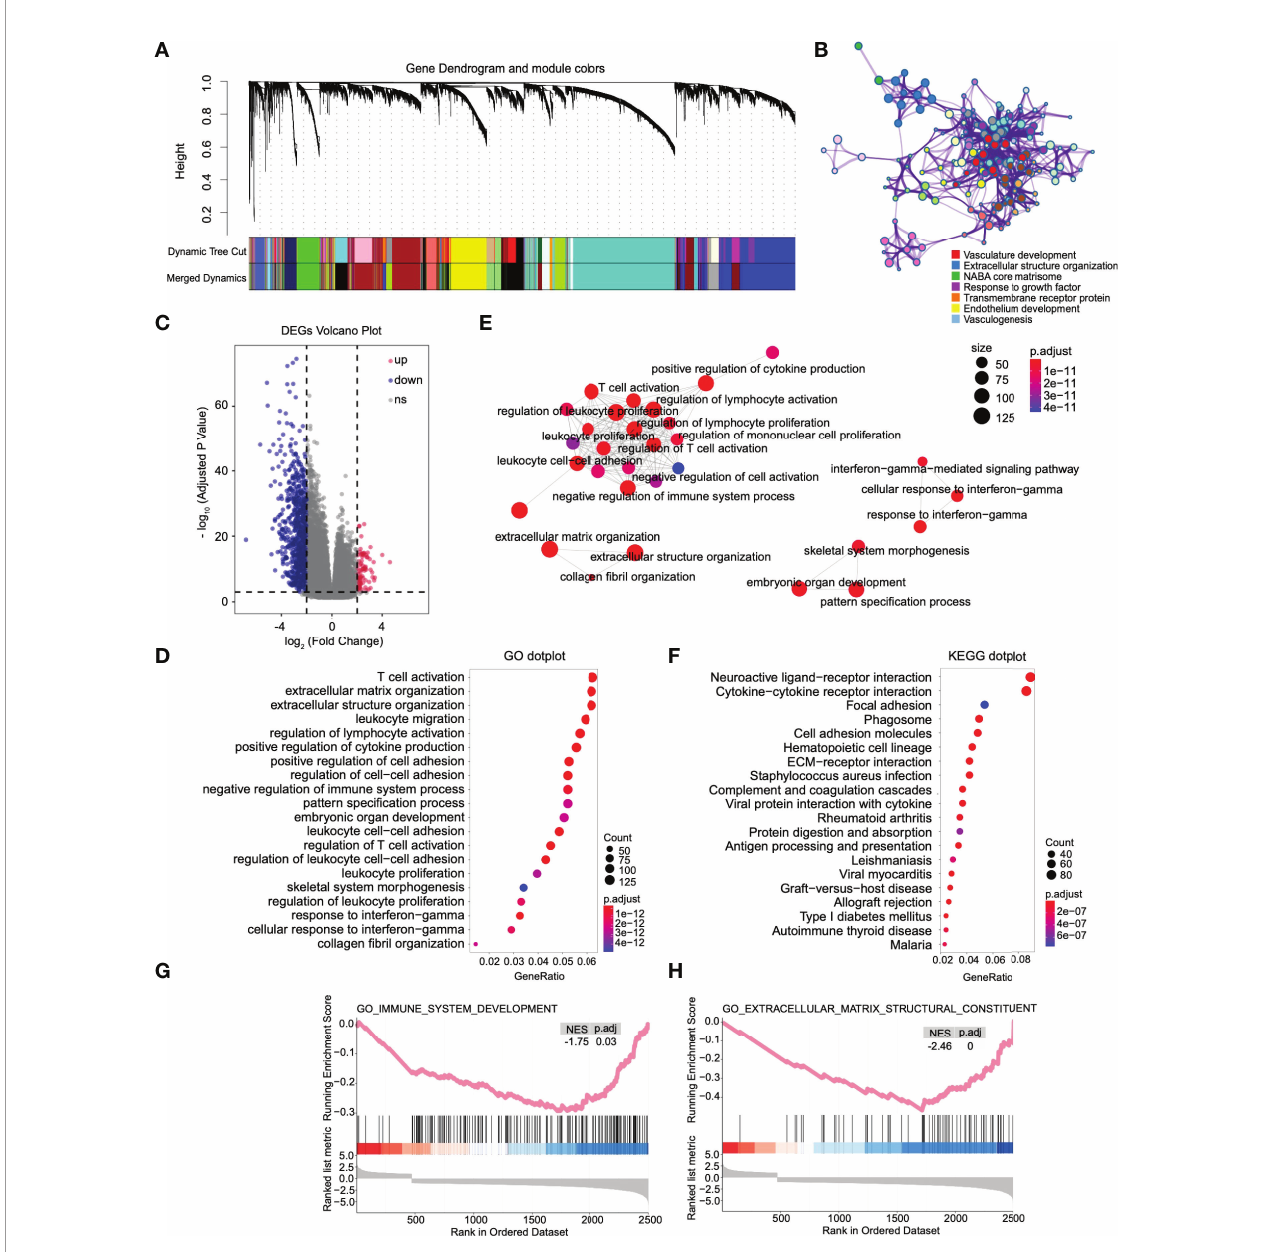
FIGURE 5 | The immune response, extracellular matrix remodeling, and other pathways were signi fi cantly activated in high-risk patients. (A) Combining the modules with slight dissimilarity, 19 weighted gene coexpression subnetworks were obtained by a dynamic tree cut algorithm. (B) GO enrichment analysis was performed on all genes in the coexpression module where mettl7b is located. (C) Volcano plot of differentially expressed genes between high- and low-risk patients. (D) Dot plot of Gene Ontology (GO) enriched terms colored by p values. (E) Signi fi cant GO items were clustered according to biological function. (F) Dot plot of Kyoto Encyclopedia of Genes and Genomes (KEGG) enriched terms colored by p values. Gene set enrichment analysis between high- and low-risk patients. There was a signi fi cant enrichment of immune (G) and extracellular matrix remodeling (H) in the high-risk group. NES, normalized enrichment